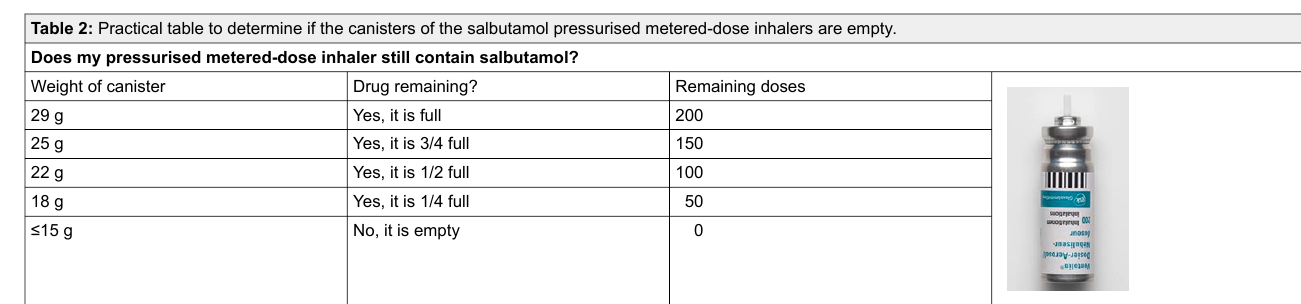
Mettler, Ohaus, and Ikea scales rounded weight to nearest 0.01 g, 1 g, and 1 g, respectively.